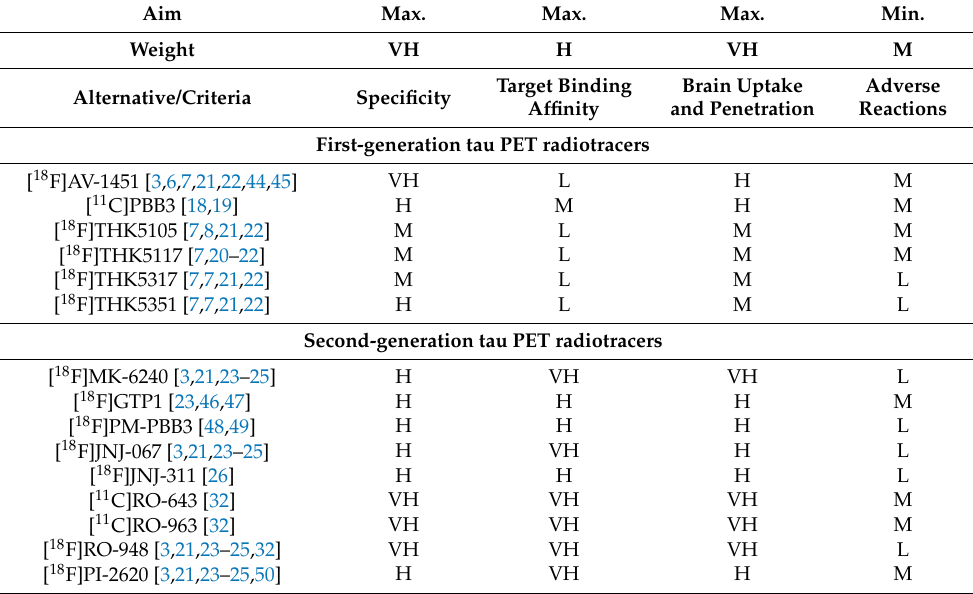
Table 2. Dataset for evaluating the tau PET radiotracers. VH: very high; H: high, M: medium; L: low; VL: very